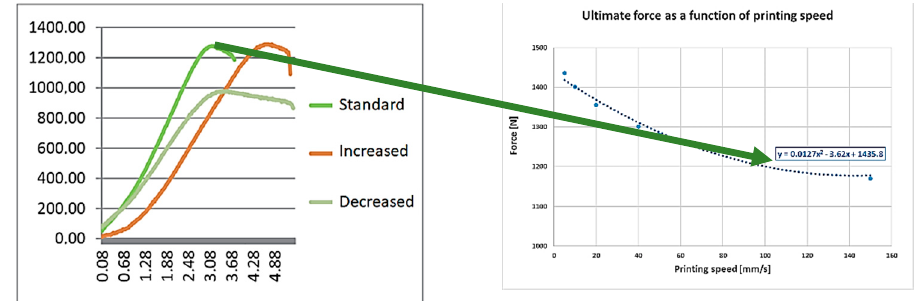
Figure 12. The tensile strength—printing speed function.